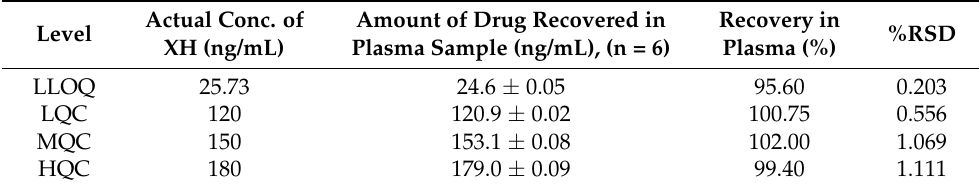
Table 2. Accuracy results for XH in plasma.